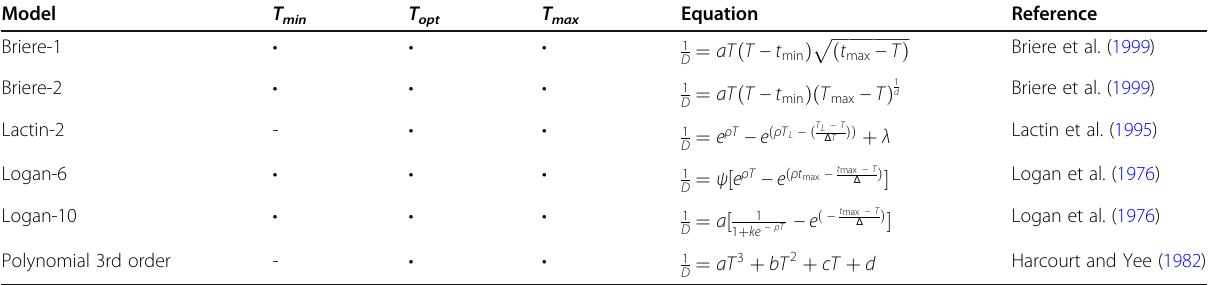
Table 1 Mathematical models used to describe the effect of temperature on the developmental rate of the common green lacewing, Chrysoperla carnea , and their capacity to estimate three important biological parameters